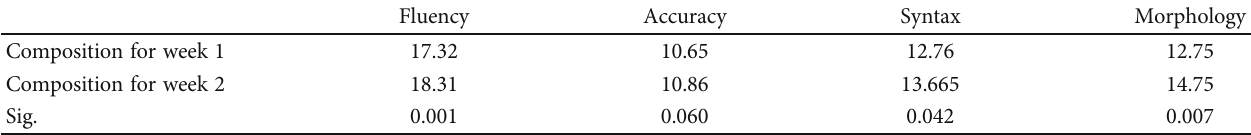
Table 4: Wechsler ’ s signed-rank test of composition for weeks 1 and 2.